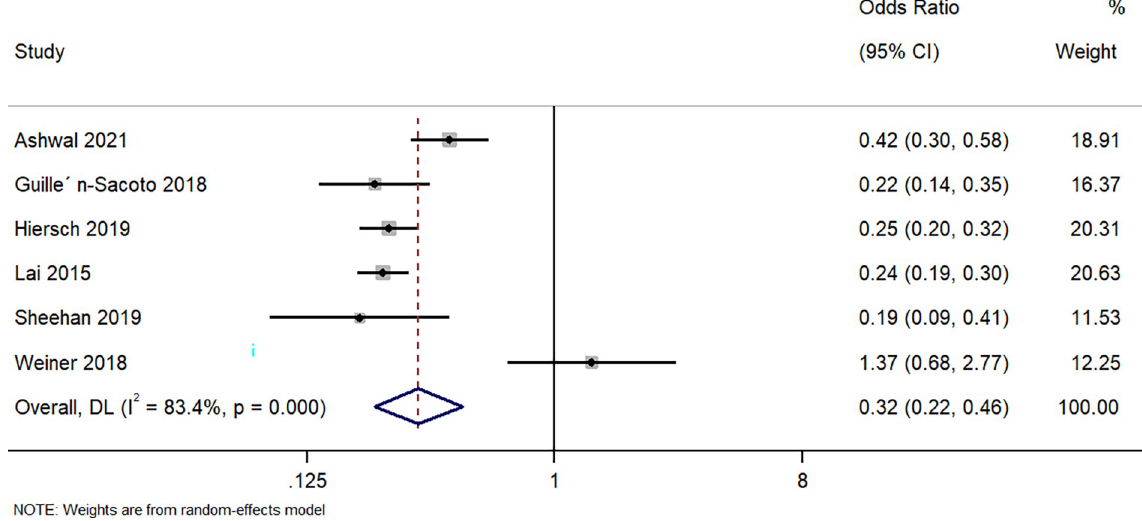
Fig 4. Forest plot showing the difference in caesarean section between women with a singleton pregnancy or twin pregnancy and GDM. NOTE: Weights are from random-effects model.